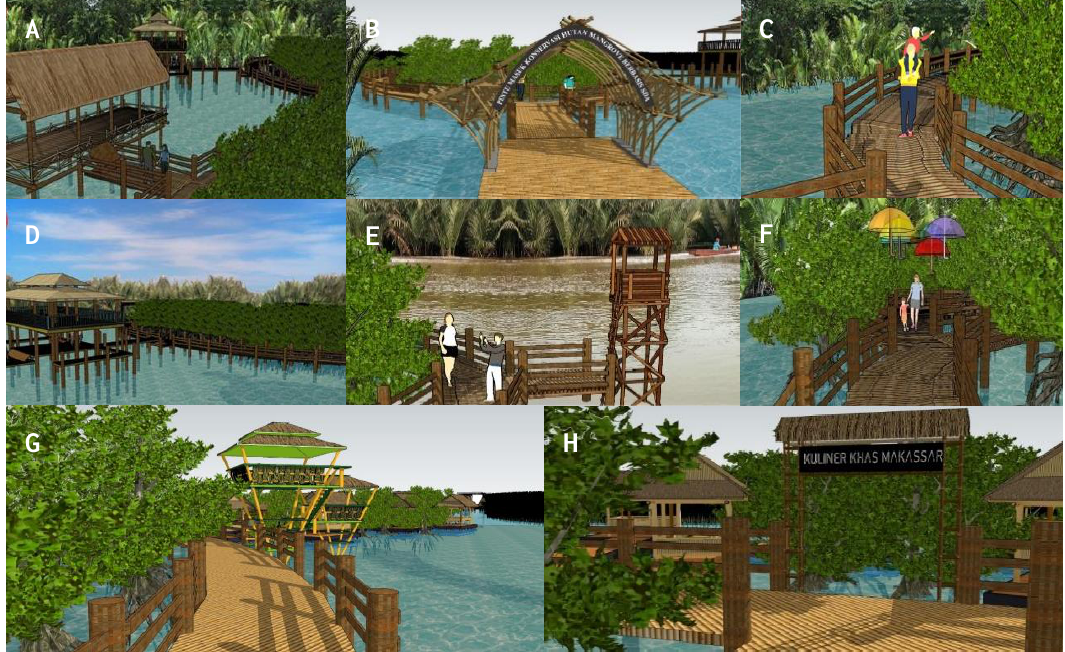
Figure 10. Example, Conservation of Tourism-Based Natural Resources and Improvement of Community Economic Productivity in the Tallo Watershed of Makassar City. Source: author elaboration.